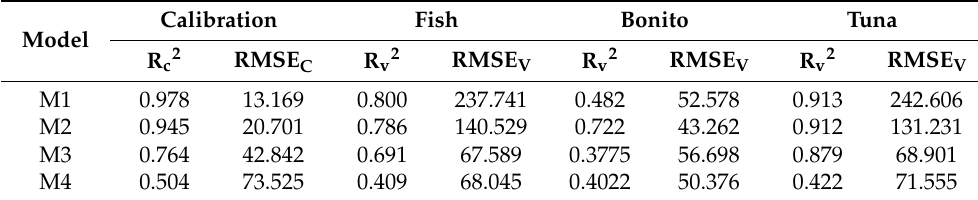
Table 3. Parameters of PLSR models based on different spectral regions (M2: 1240–1350 & 1500–1600 cm − 1 ; M3: 1264, 1268, 1304, 1320, 1437 & 1570 cm − 1 ; M4: 1268; 1320, 1570 cm − 1